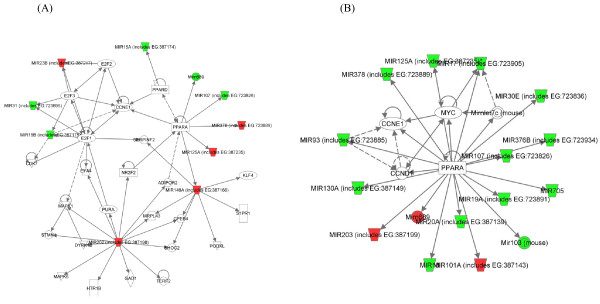
Network analysis of miRNAs the expression of which in TM4 cells was altered by NP (A) 3 h. (B) 24 h. Network analysis was performed using an algorithm supported by IPA. A best-matched network map was created.